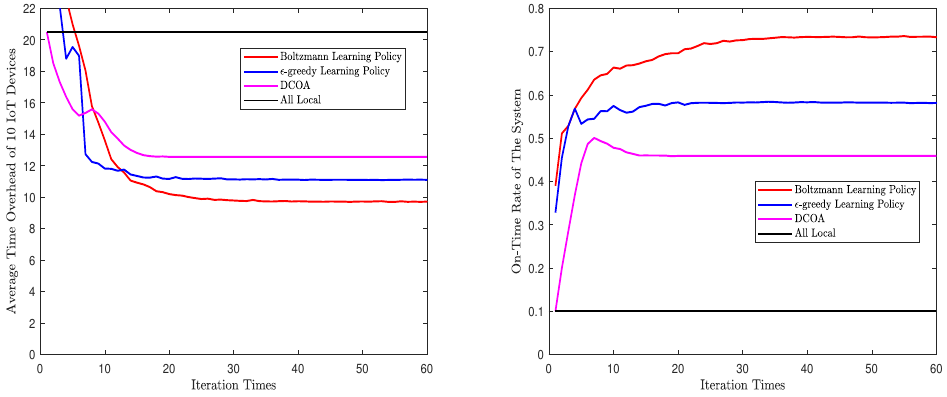
Figure 4. Convergence processes of different algorithms with 10 IoT devices.